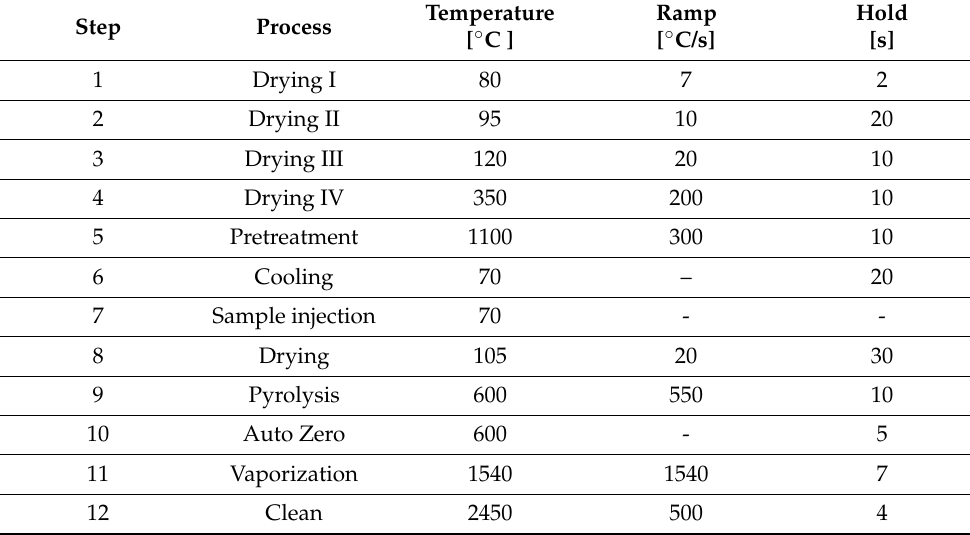
Table 1. Graphite furnace temperature/time program for Pd/Zr modifier and Ga deposition on graphite furnace (steps 1–5); addition of sodium acetate and ruthenium modifier (step 6). Sample thermal pretreatment (steps 7 to 10) and GaF molecules evaporation (step